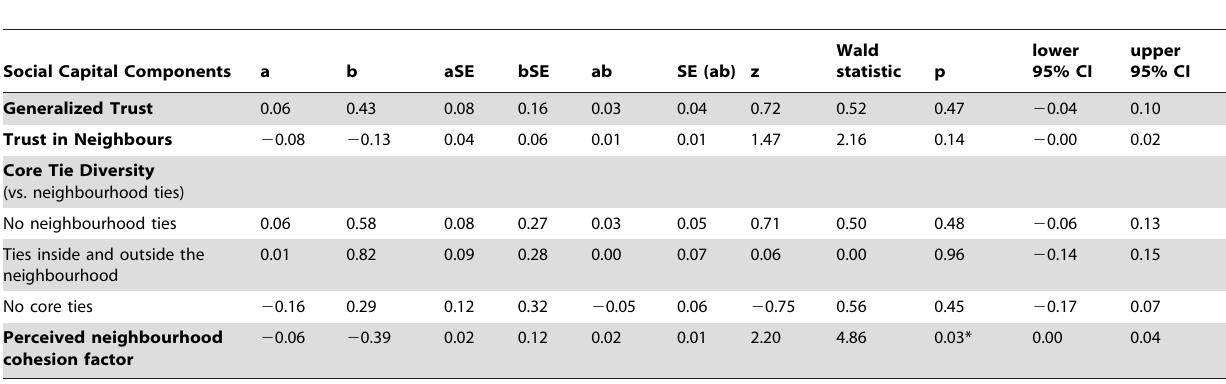
Table 3. Mediation analyses: social capital variables as mediators of neighbourhood disadvantage and depressive symptoms in women, n=